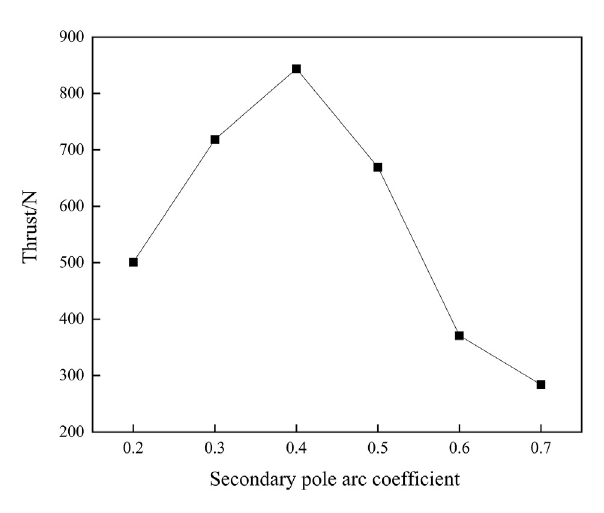
FIGURE 6 FFT factoring of the air gap fl ux density.